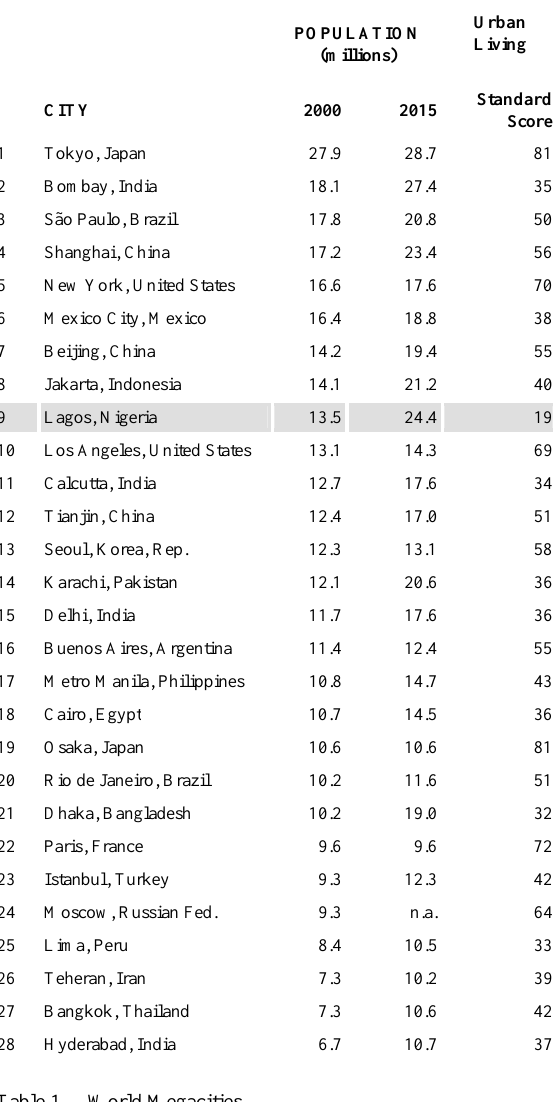
Table 1. World Megacities (Source: United Nations (U.N.) Population Division, World Urbanization Prospects,